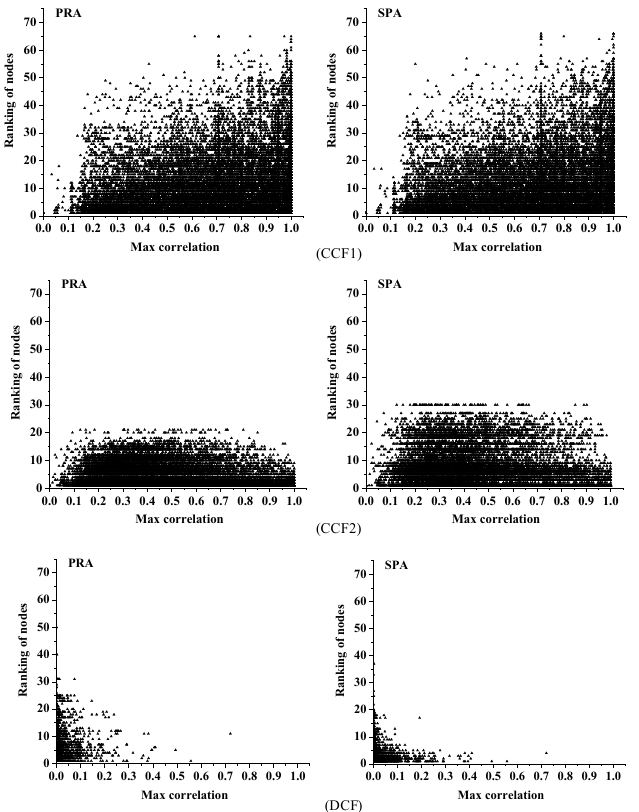
Figure 17. Relationship between the importance of nodes and their maximum relevance to the TR.